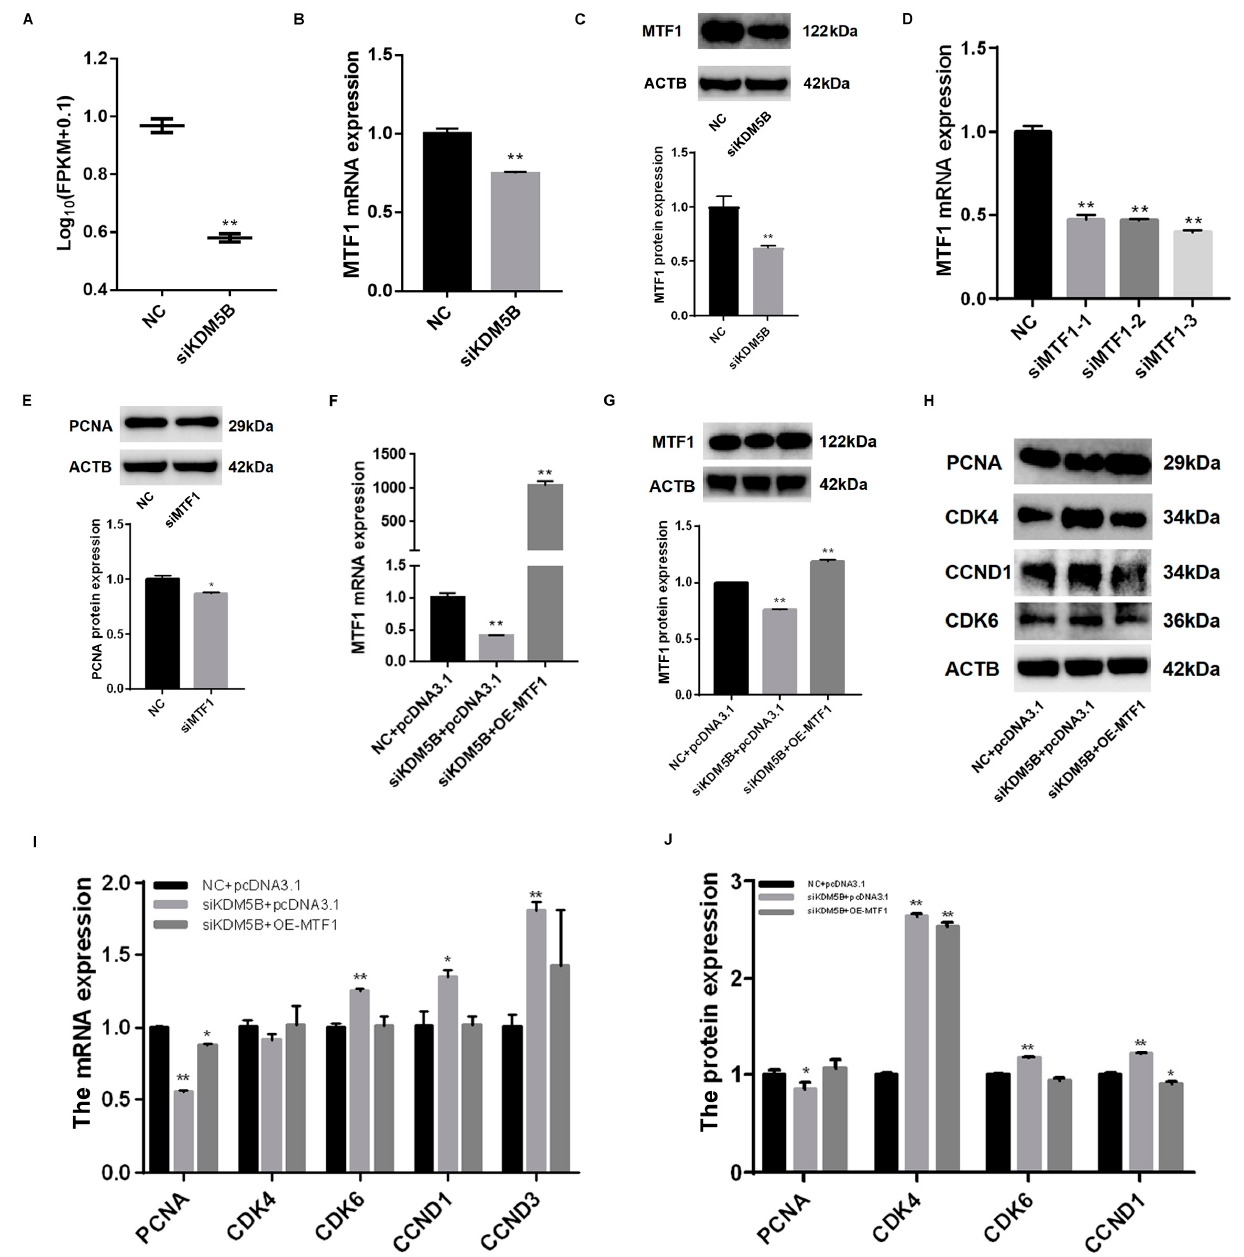
Figure 6. KDM5B maintains normal cell proliferation and cell cycle in GCs via MTF1. ( A , B ) mRNA expression of MTF1 significantly decreases after the knockdown of KDM5B. ( C ) Protein expression of MTF1 significantly decreases after the knockdown of KDM5B. ( D ) Knockdown efficiency result shows that siMTF1-3 is the most efficient. ( E ) Protein expression of PCNA significantly decreases after the knockdown of MTF1. ( F , G ) mRNA expression of MTF1 significantly decreases after the knockdown of KDM5B, and mRNA and protein expressions of MTF1 significantly increase after the simultaneous knockdown of KDM5B and overexpression of MTF1. ( H – J ) mRNA and protein expressions of PCNA decrease significantly and rebound after the simultaneous knockdown of KDM5B and overexpression of MTF1. mRNA and protein expressions of CDK4, CDK6, CCDN1 and CCND3 increase in the KDM5B knockdown GCs and fall back after the simultaneous knockdown of KDM5B and overexpression of MTF1. * means p < 0.05, and ** means p <